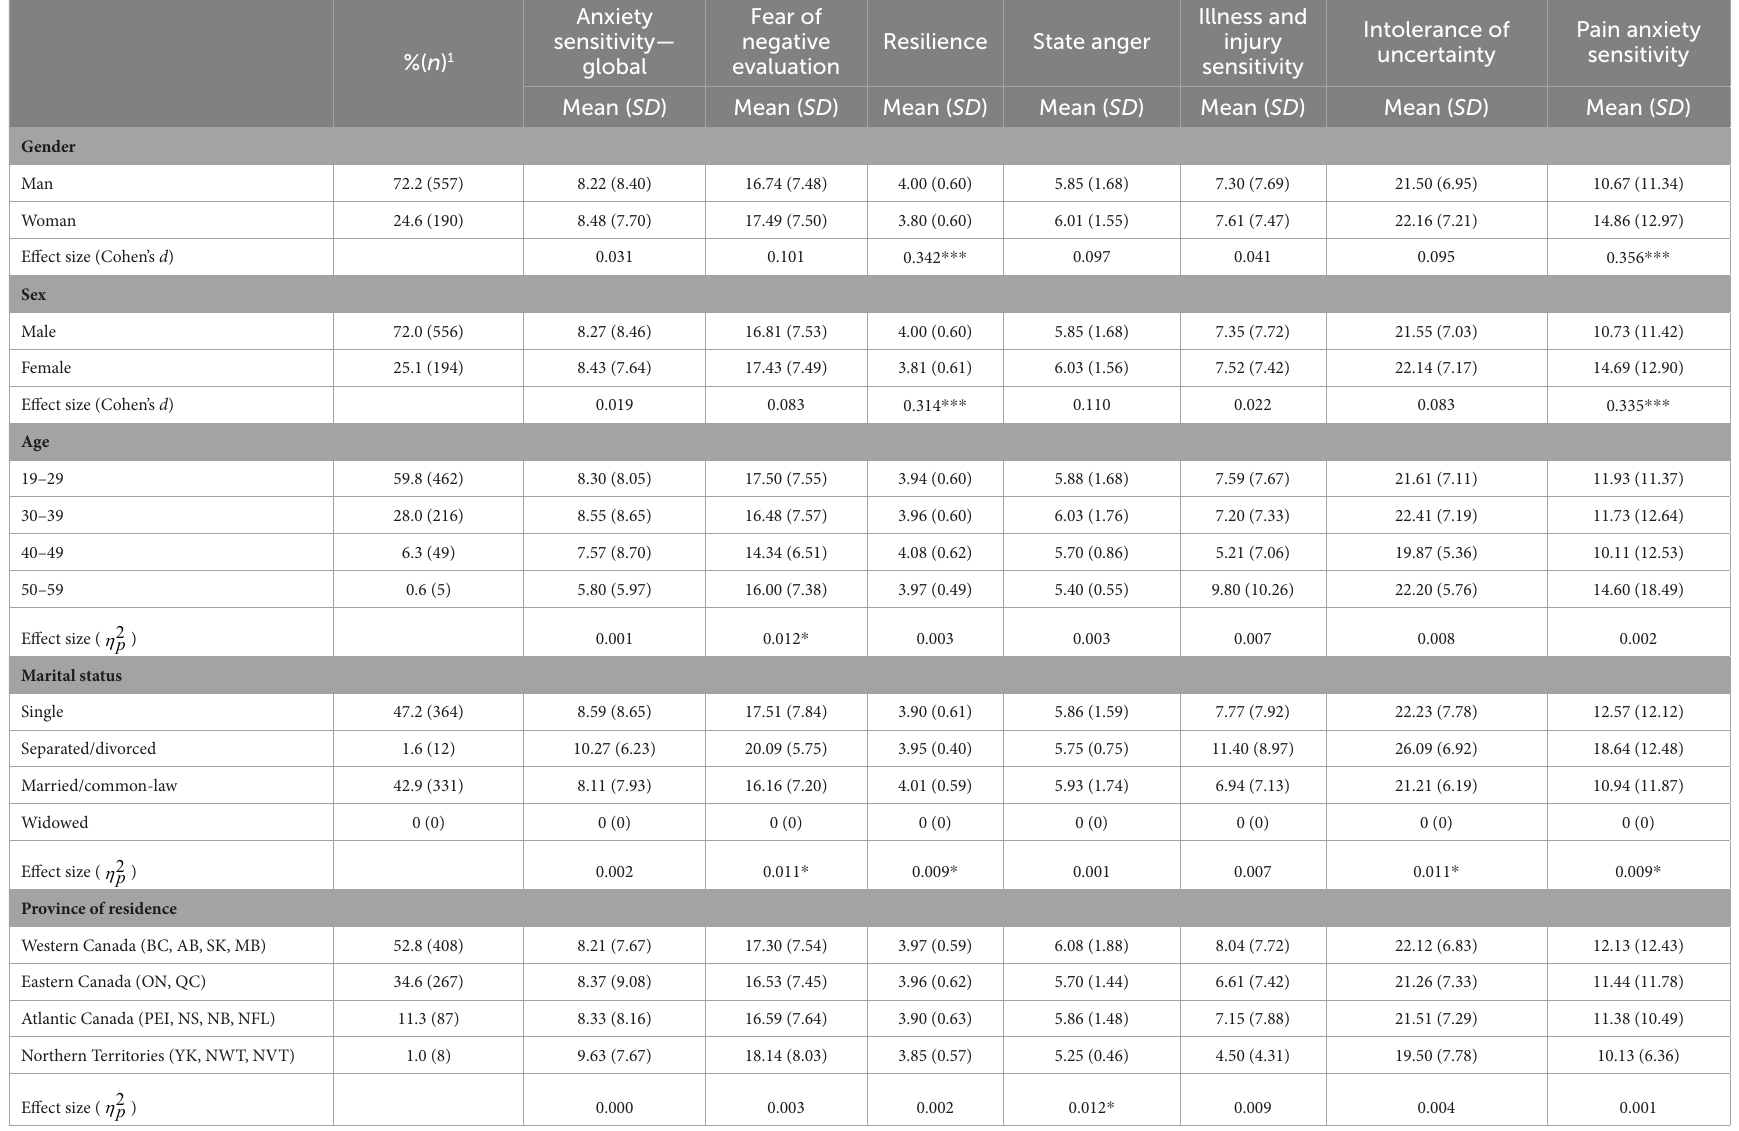
TABLE 2 Sociodemographic characteristics and comparison of putative risk and resiliency outcomes scores among different categories.